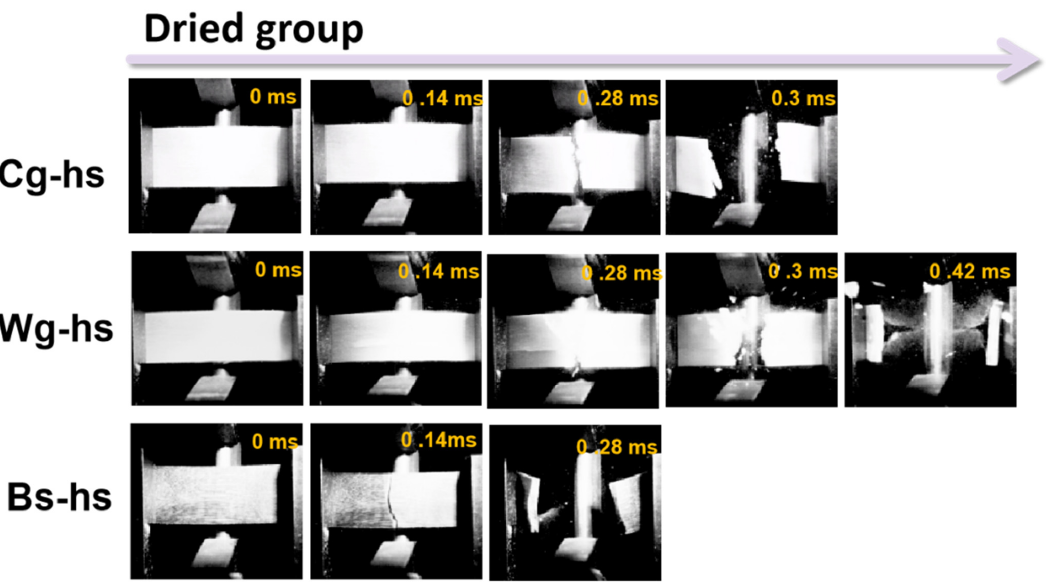
Figure 5. High ‐ speed camera images of impact process for the three Caprinae horn sheaths (Dried group).